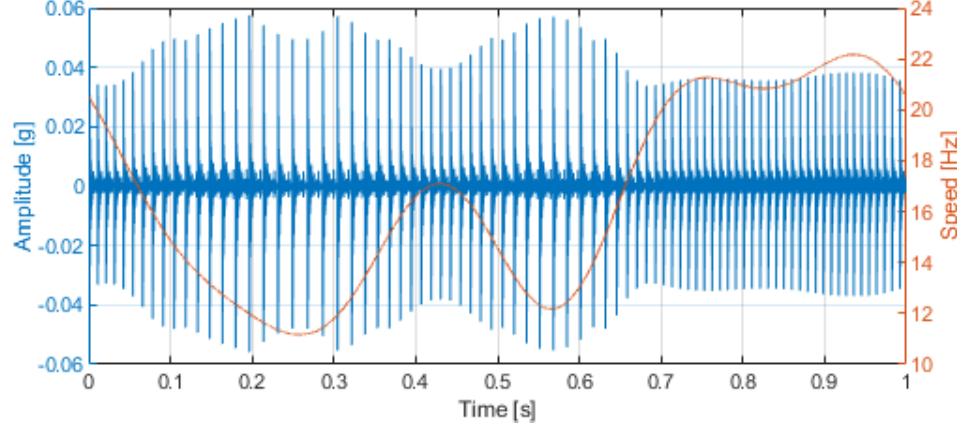
Figure 13. Resultant REB signal with instantaneous speed profile.